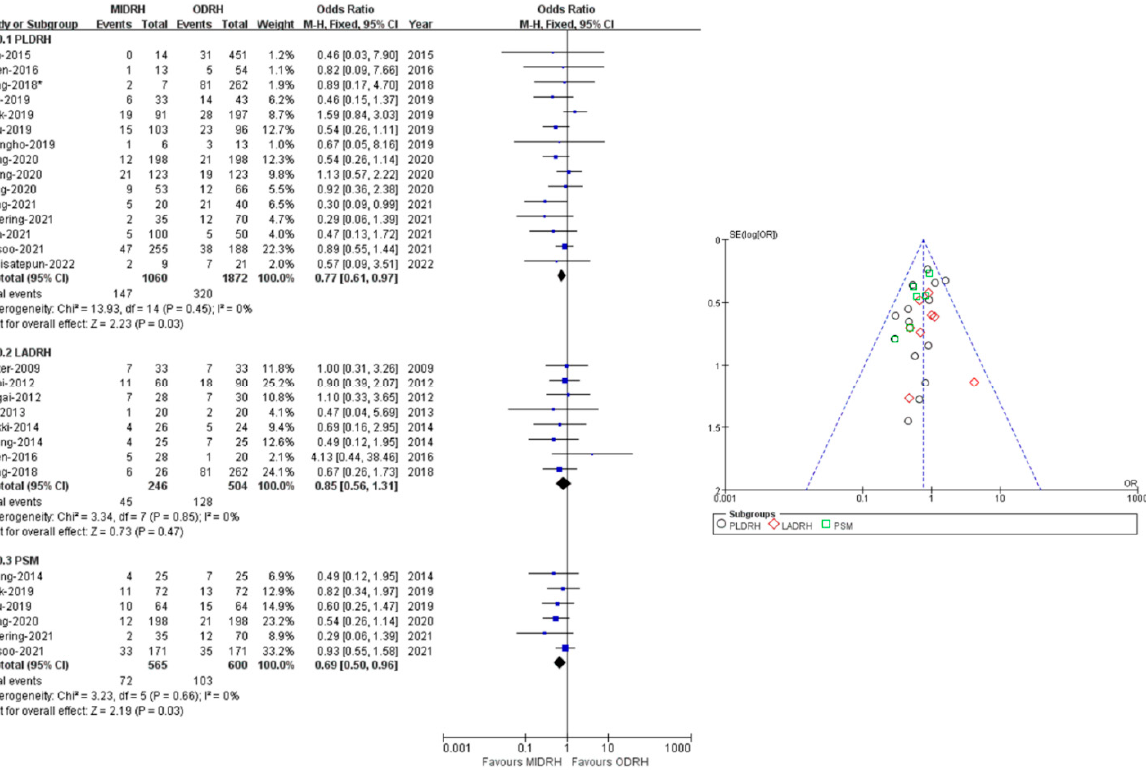
Figure 10. Forest plot and funnel plot comparison of MIDRH versus ODRH for overall complications [4,5,7,12–27,29–31]. * ： Different data in the same article .